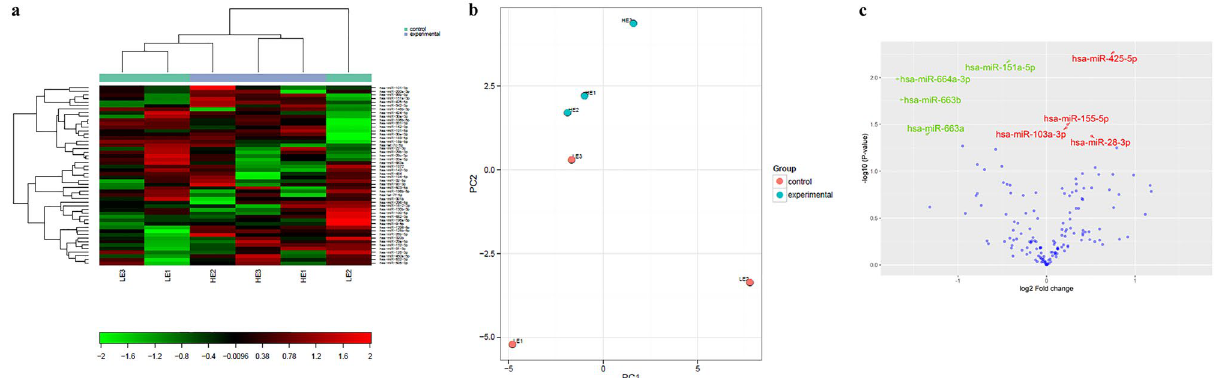
Figure 2. miRNA profiling by Real-Time PCR identified differentially expressed miRNAs in HK-2 derived exosomes under hyperglycaemia. ( a ) Heat map and unsupervised hierarchical clustering. Clustering was performed in all the samples for the top 50 miRNAs with the highest standard deviation. The color scale shown at the bottom illustrates the relative expression level of a microRNA across all samples: red color represents an expression level above the mean, and green color represents expression lower than the mean. ( b ) Principal Component Analysis was performed on all the samples and the top 50 miRNAs with the highest standard deviation. The normalized (dCt) values have been used for the analysis. ( c ) The volcano plot shows the relation between the P - values and the fold change. Highlighted spots are microRNAs with p < 0.05 after Benjamini–Hochberg correction for multiple testing. The significantly upregulated miRNAs are shown in red while downregulated miRNAs are shown in green color. miRNAs, Micro Ribonucleic Acid; PCA, Principal Component Analysis; LE1, LE2, LE3, Low glucose treated HK-2 cells-derived exosomes from three different samples (control); HE1, HE2, HE3, High glucose treated HK-2 derived exosomes from three different samples (experimental).